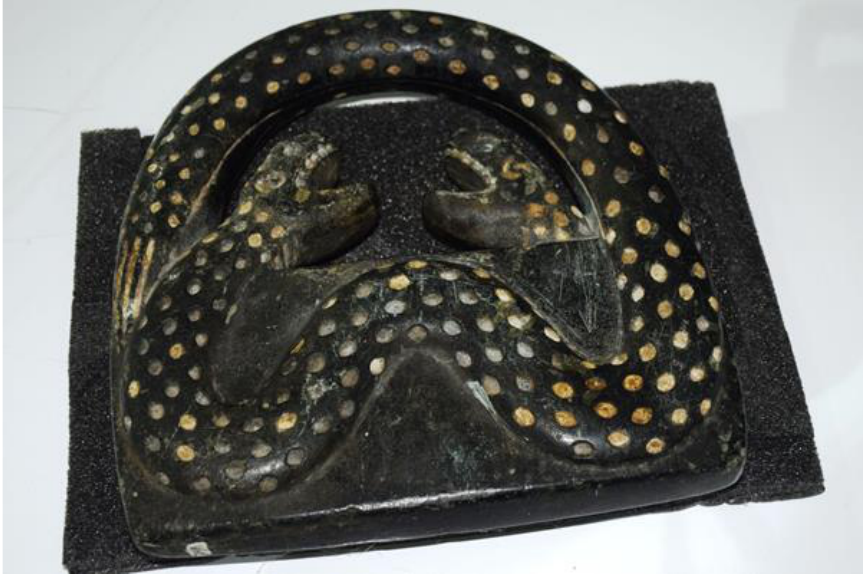
Figure 2. “Snake” figure in the State Museum of the History of Uzbekistan in Tashkent.